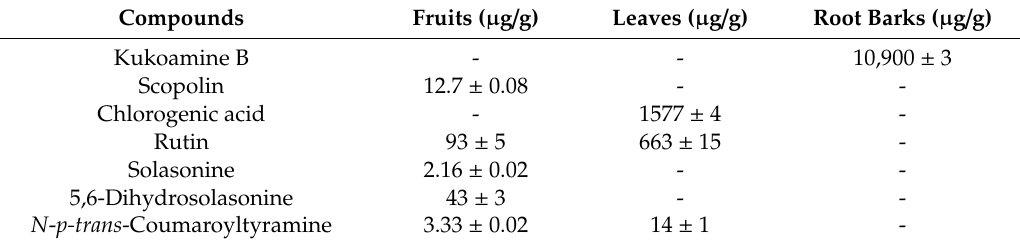
Table 2. The amounts of seven standards in 1 g dry fruits, leaves and root barks. Compounds Fruits ( µ g / g) Leaves ( µ g / g) Root Barks ( µ g / g) Kukoamine B - - 10,900 ± 3 Scopolin 12.7 ± 0.08 - - Chlorogenic acid - 1577 ± 4 - Rutin 93 ± 5 663 ± 15 - Solasonine 2.16 ± 0.02 - - 5,6-Dihydrosolasonine 43 ± 3 - - N - p-trans -Coumaroyltyramine 3.33 ± 0.02 14 ± 1 - Results are expressed as means ± SD, n =